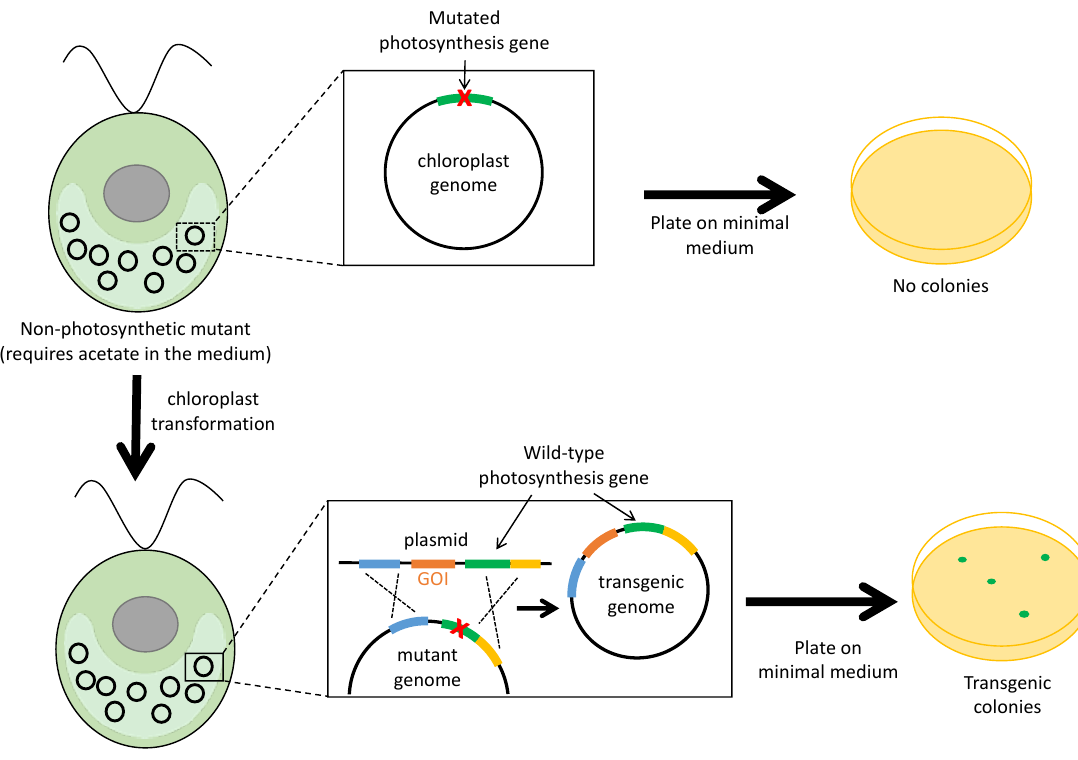
Figure 4. Selection based on photosynthetic rescue. The recipient C. reinhardtii strain is incapable of phototrophic growth owing to a deletion or point mutation in an essential photosynthesis gene and must be maintained on acetate-containing medium. Transformation of the recipient with donor DNA including the wild-type version of the gene results in restoration of photosynthesis and concomitant integration of the GOI, enabling transformants to grow on a minimal medium.